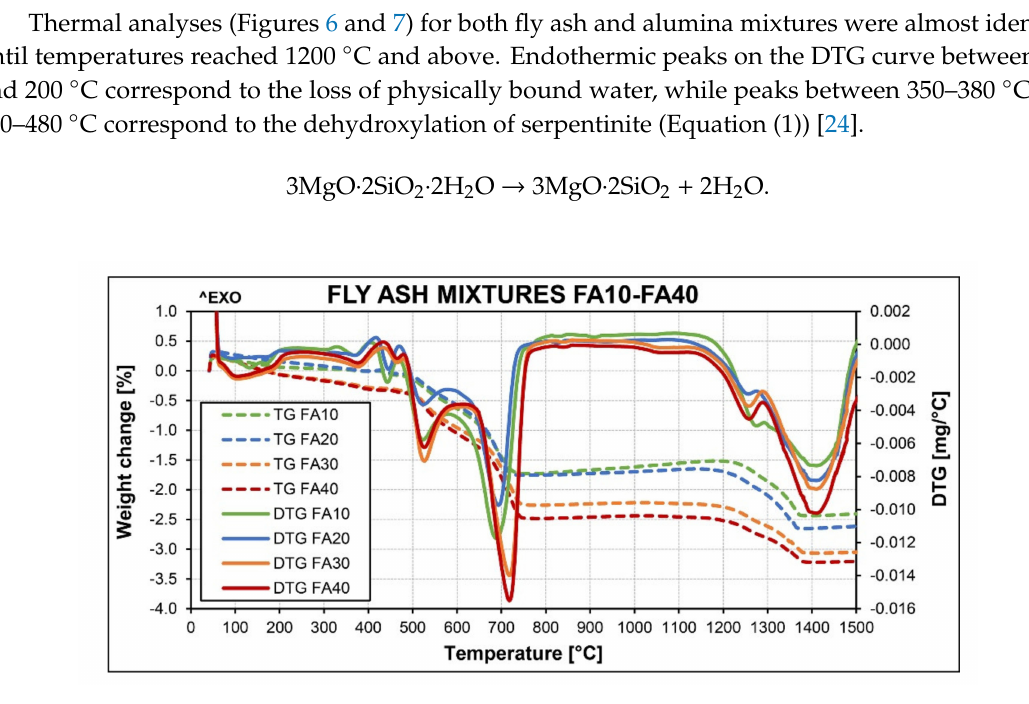
Figure 6. Thermal analyses of mixtures with fly ash